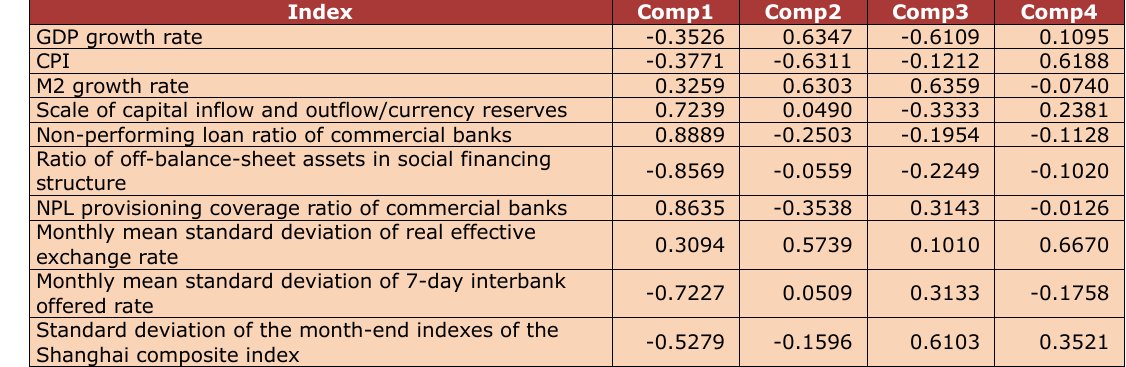
Table 3. First Four Principal Component loadings(unrotated)